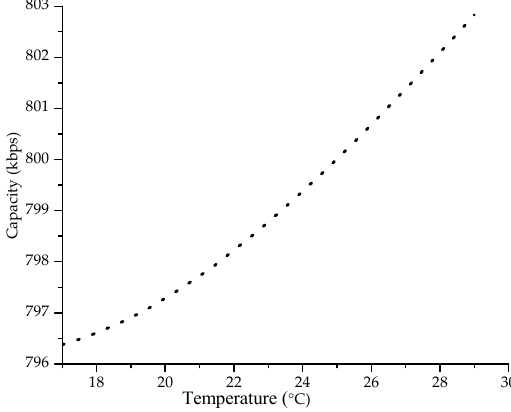
Figure 7. Average capacity versus temperature.